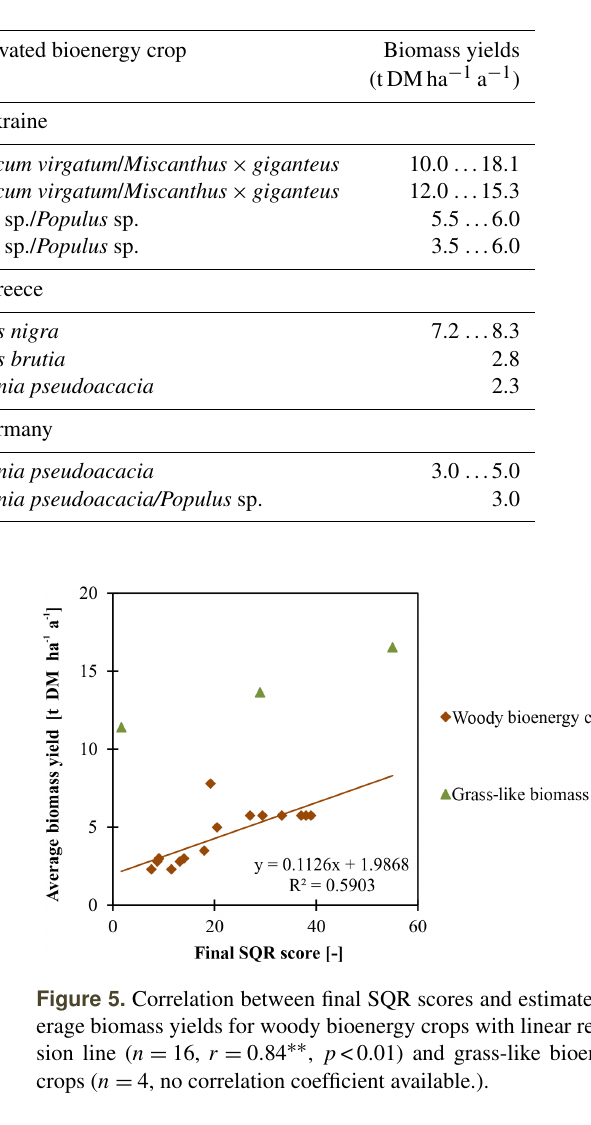
Table 5. Average biomass yields at case study sites: ranges for different degrees of soil marginality (data provided by regional project partners).